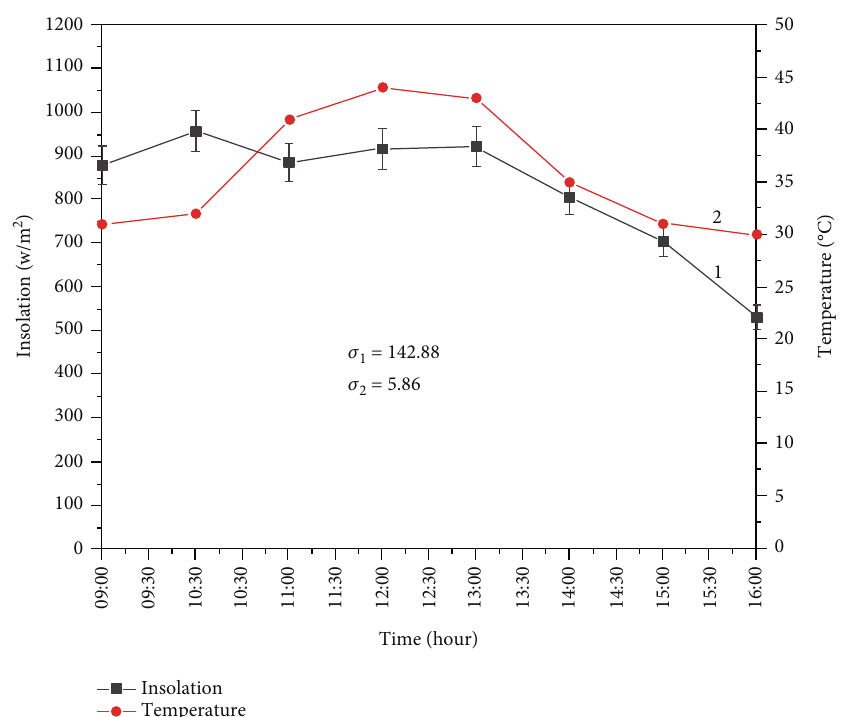
Figure 4: The e ff ect of solar radiation on outlet air temperature.